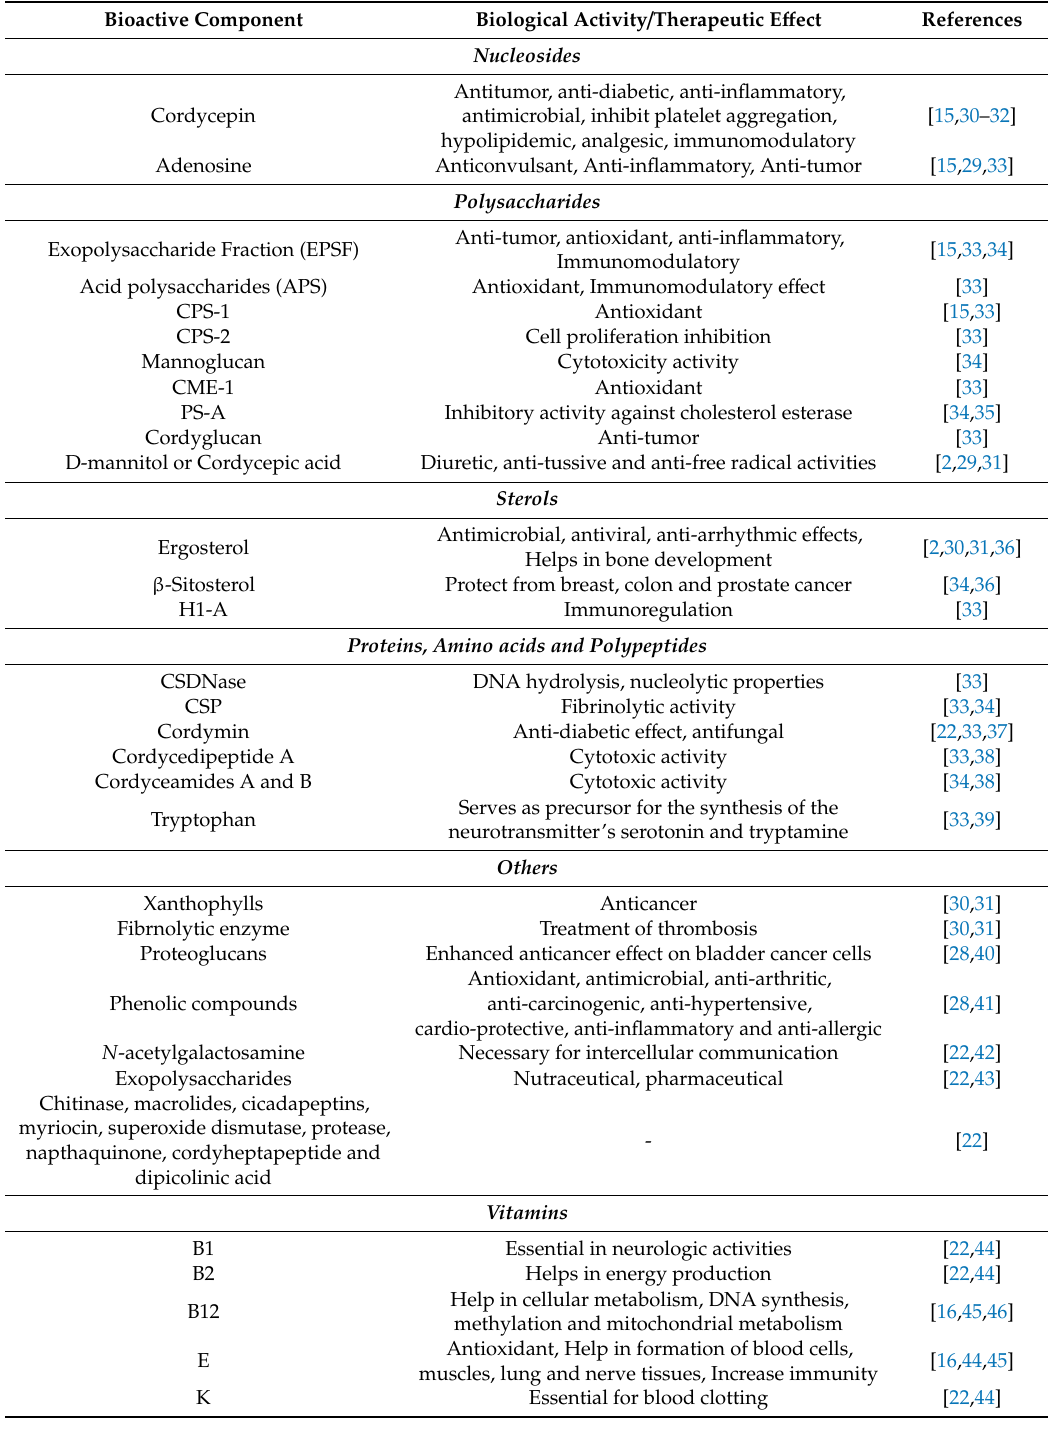
Table 1. List of bioactive components present in Cordyceps with their biological activities and implication in